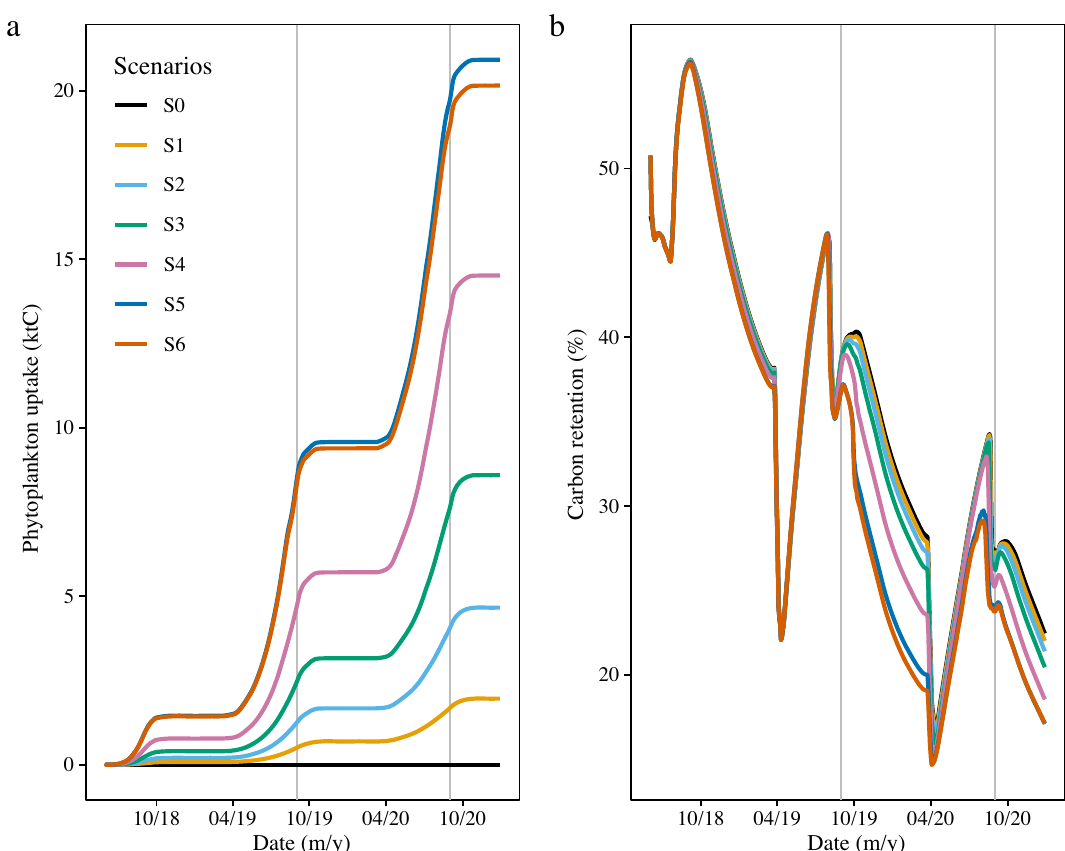
Fig. 10. Time series of (a) cumulative phytoplankton uptake and (b) carbon retention in scenarios 0 through 6. Vertical grey lines represent September 1, 2019 and September 1, 2020